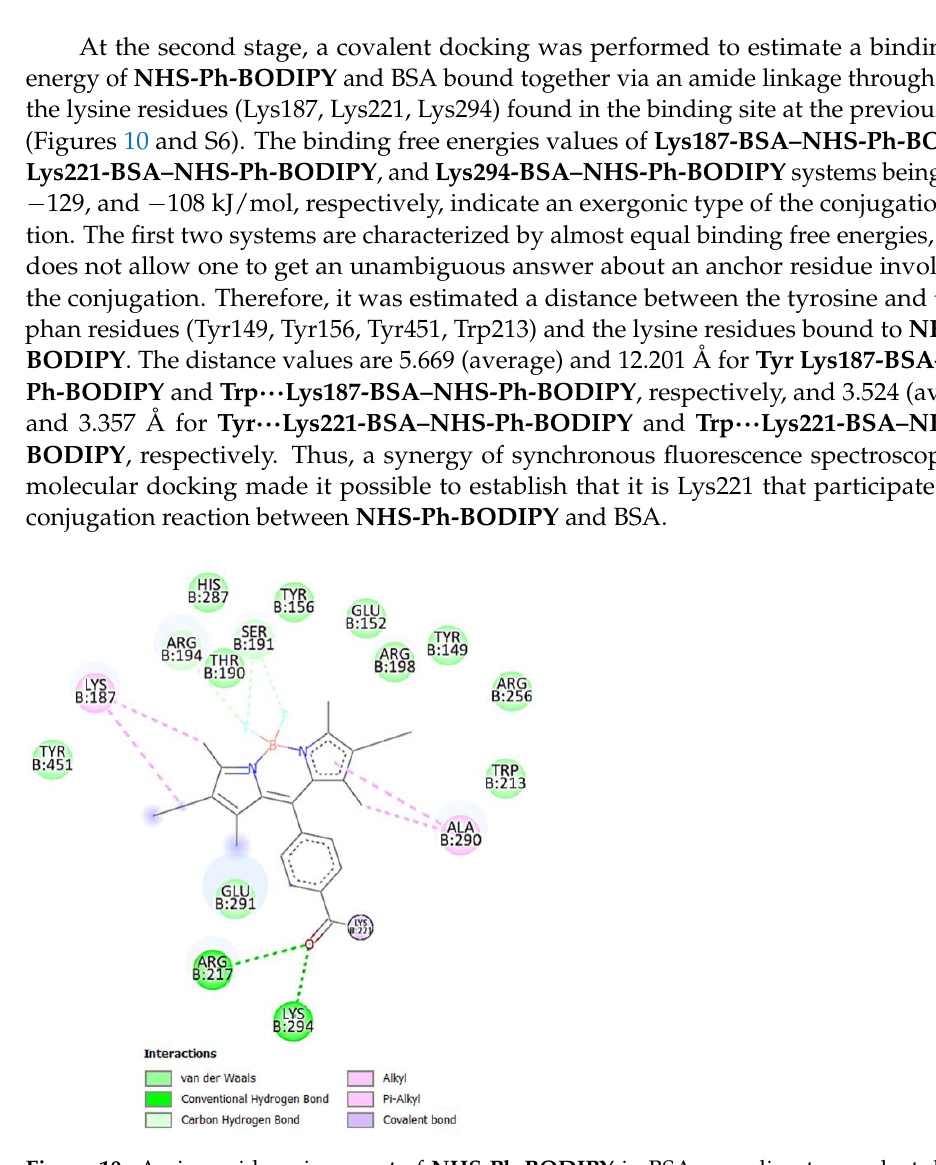
Figure 11. Binding site of NHS-Ph-BODIPY in PotN ( a ) and its amino acid composition ( b ) ac- cording to blind docking results. It is noteworthy that the molecular docking results give explanation for a difference in sensitivity of BSA and PotN detection with NHS-Ph-BODIPY (Section 2.4). As stated above, the BSA binding site contains three lysine residues, while the PotN binding site contains only one lysine residue. Thus, lower detection limit for BSA than for PotN may be due to a higher probability of NHS-Ph-BODIPY to bind lysine residues at the bind- ing site of the first protein than the second one.